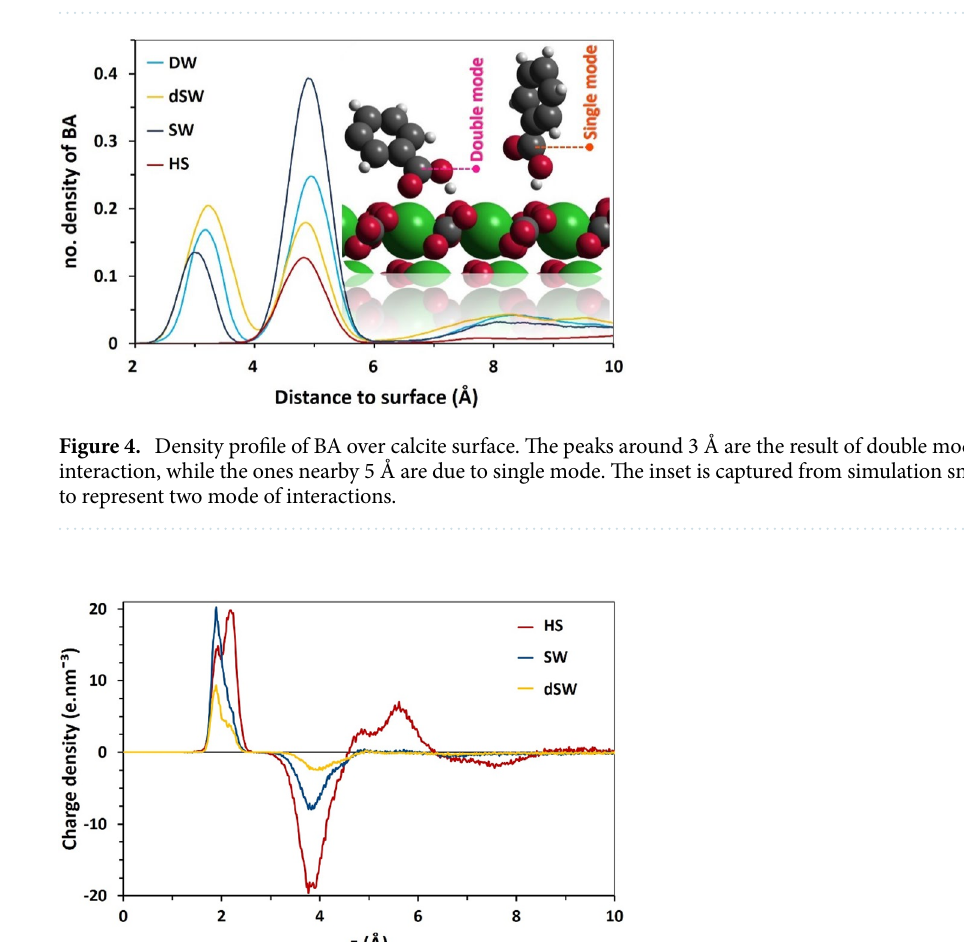
Figure 3. The final simulation snapshots of SW (left) and HS (right). The atoms/ions are drawn with the sizes of their radii. Water molecules are omitted for clarity. The same snapshots for DW and dSW are shown in Figure S3. The atom colors are: Ca; green, C; grey, O; red, H; white, Na; purple, Cl; yellow.